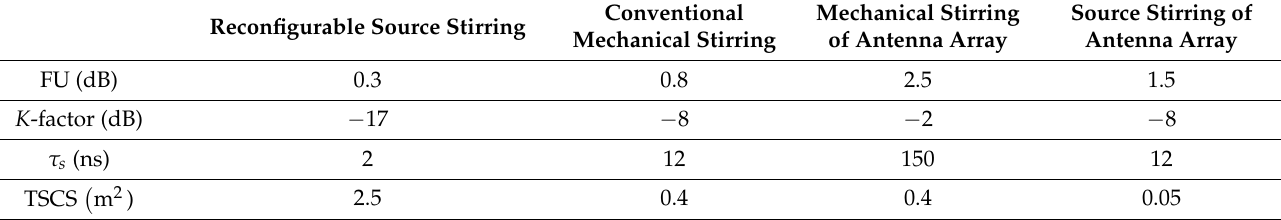
Table 2. Comparison of mean value between the proposed work with other stirring methods in an RC . Reconfigurable Source Stirring